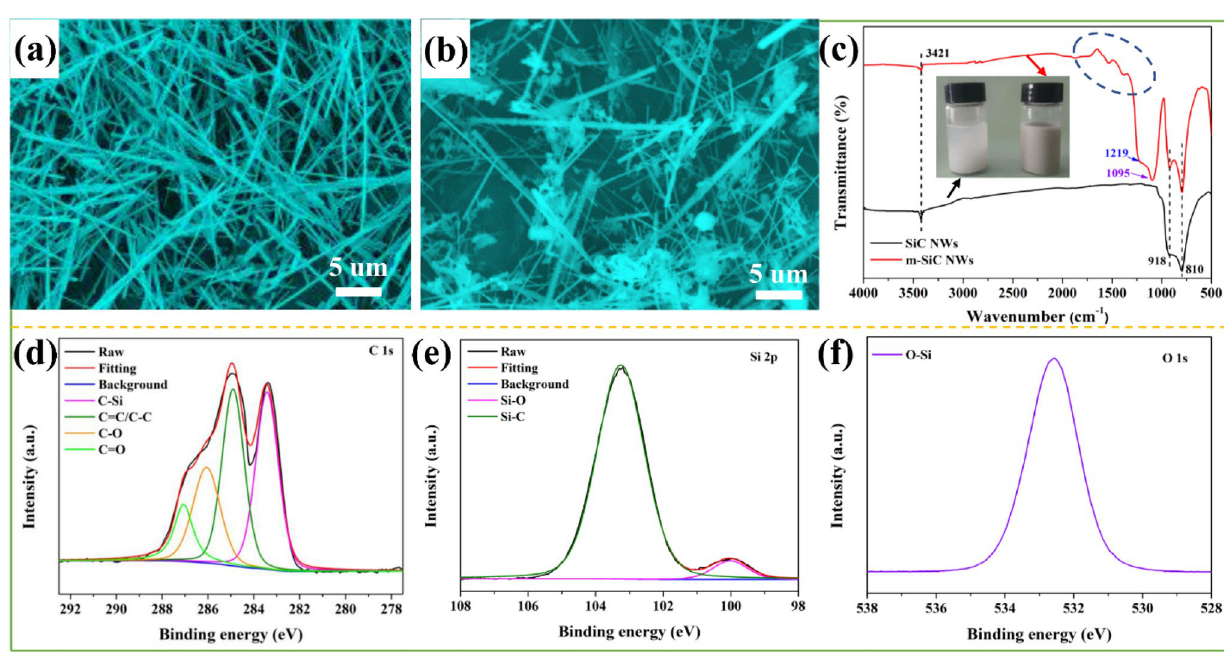
Fig. 2 Characterizations of commercial SiC NW S and m‑SiC NW S . a, b are SEM images of commercial SiC NW S and m‑SiC NW S . c FT‑IR spectra of SiC NW